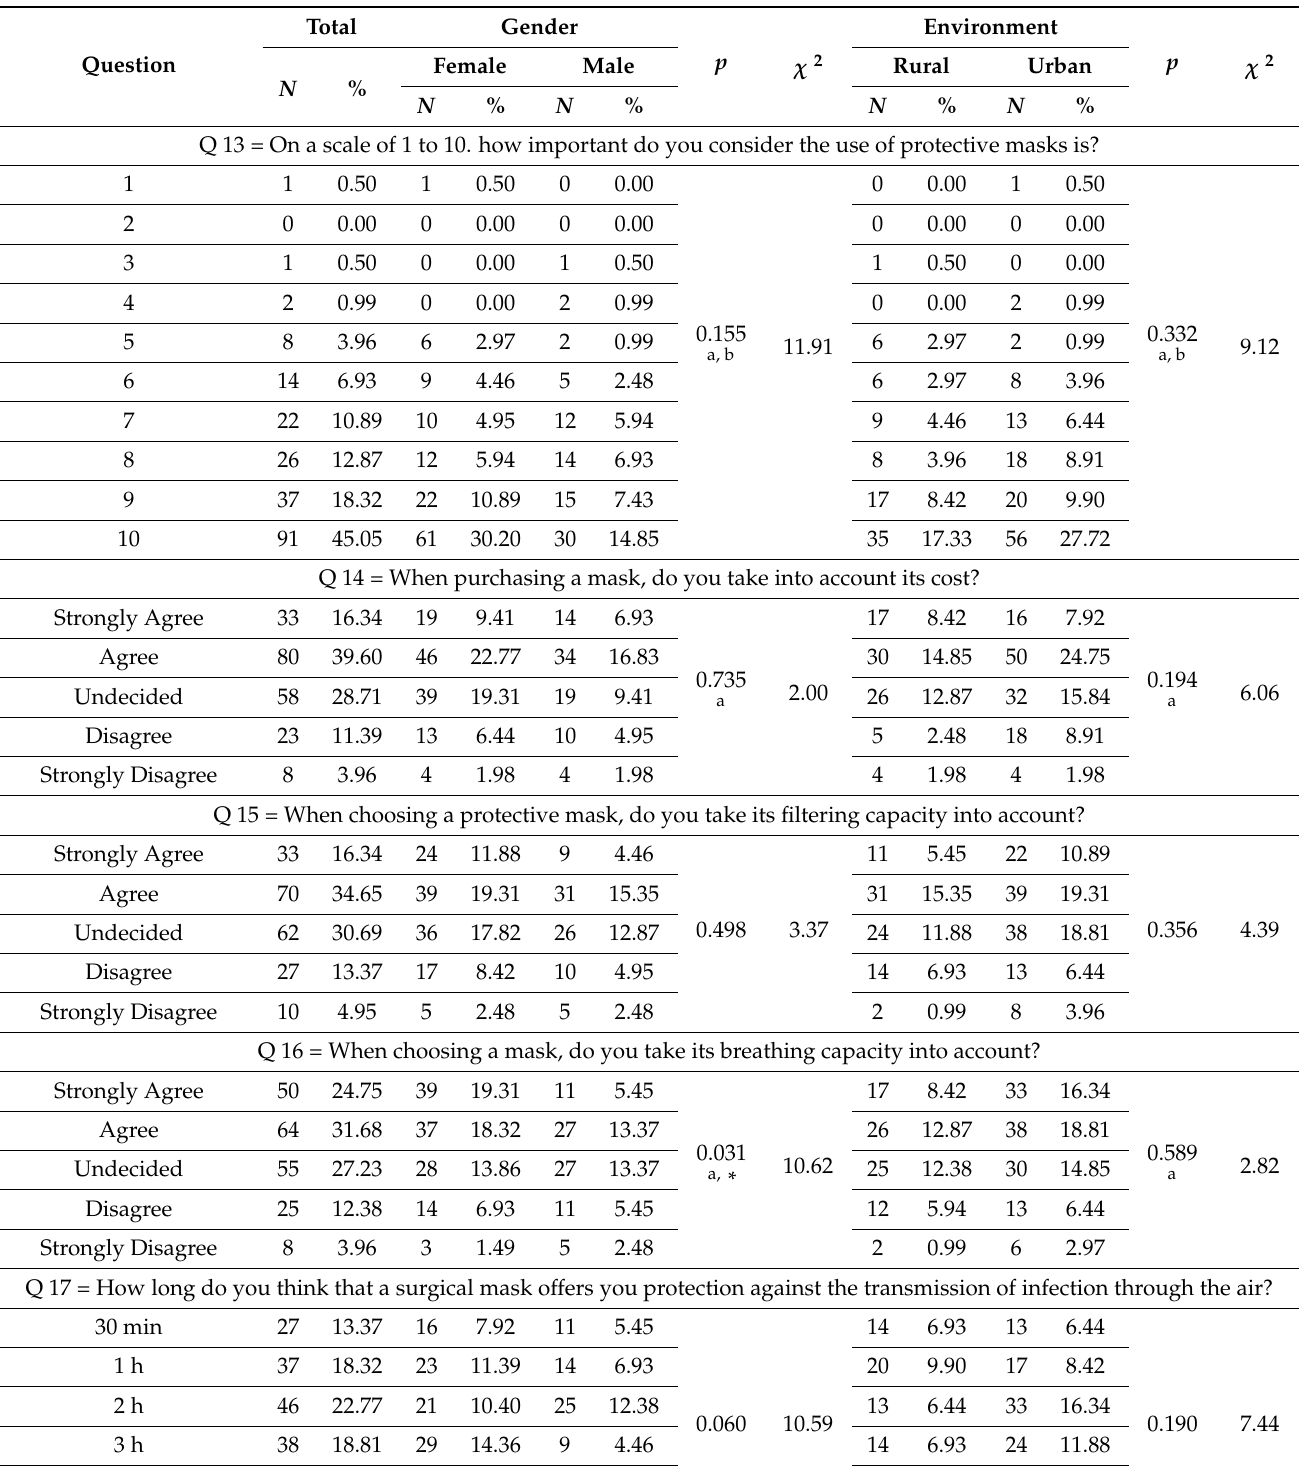
Table 3. Distribution of responses regarding the subjects’ attitude towards the use of protective